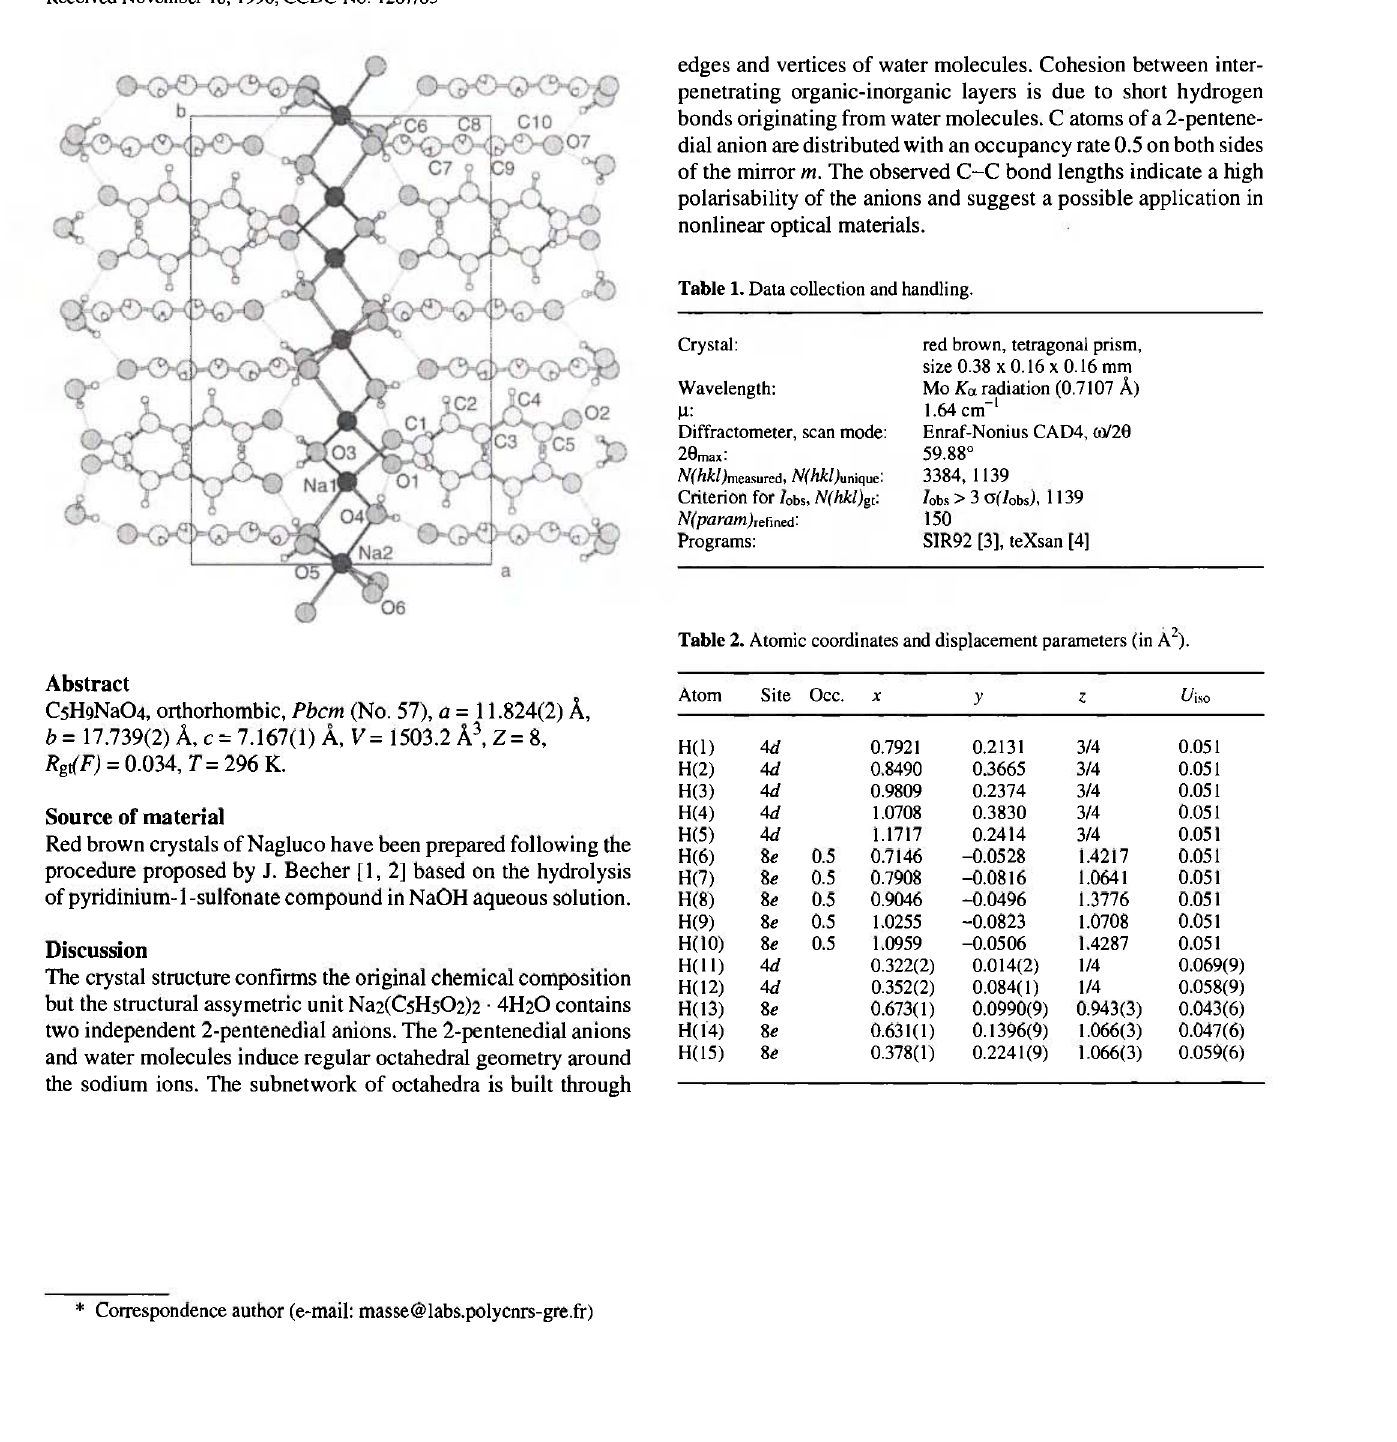
Table 2. Atomic coordinates and displacement parameters (in A 2